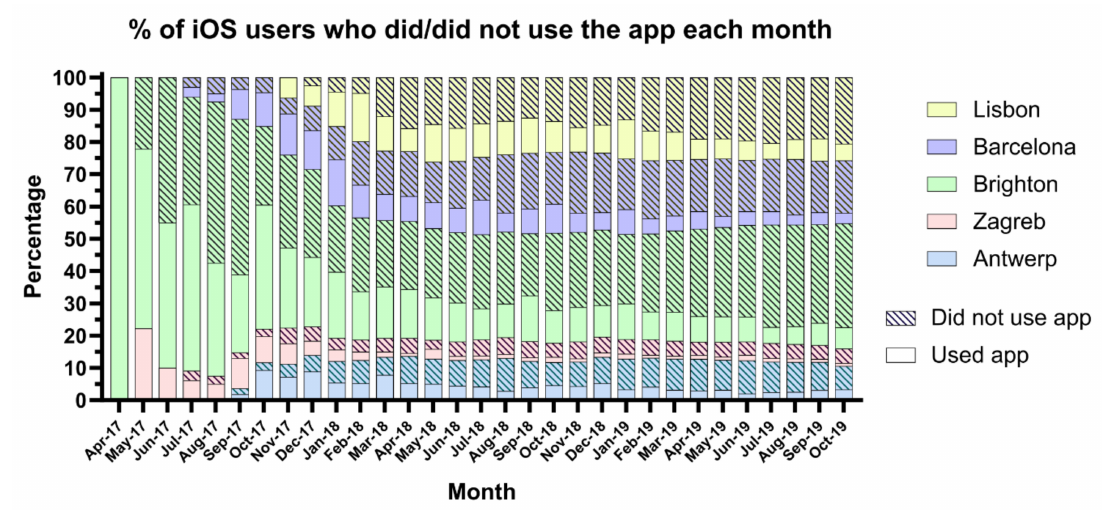
Figure 4. % of iOS users who did/did not use the app each month at each clinical